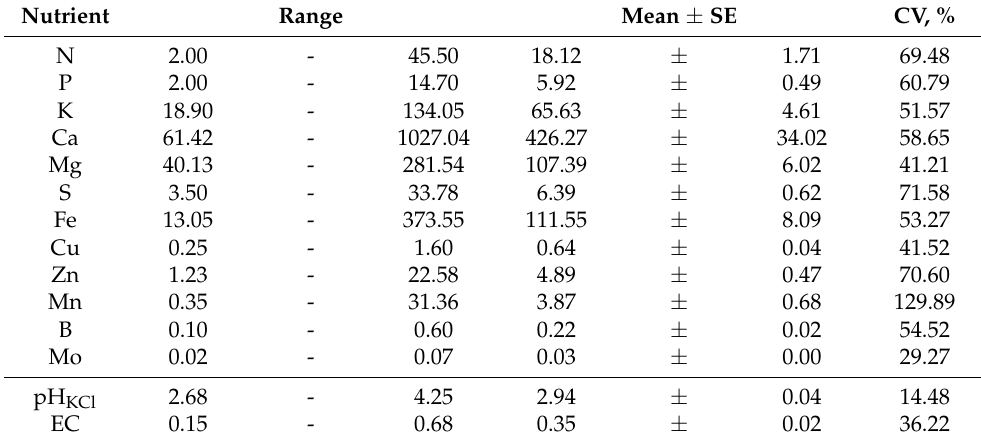
EC 0.15 The average Ca:Mg ratio in the soils of the study sites was 4.06 ± 0.32, ranging from 0.69 (Kaigu Bog) to 7.71 (Raganu Bog), thus indicating on the possible impact of different soil bedrock in different locations. The PCA of the results of peat analysis revealed three principal components (eigen- value > 1.0) that explained 70.7% of the total variance (Figure 4).